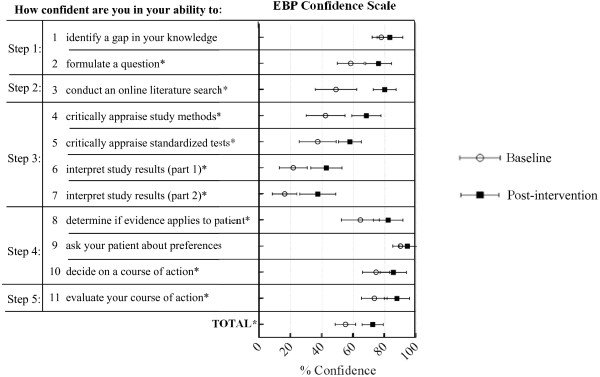
Illustrates pre-post group mean scores on individual items of the Evidence Based Practice Confidence (EPIC) Scale. Evidence based practice step (1-5) corresponding to each item is indicated on the left. Open circles indicate baseline mean, closed boxes indicate post-program mean, horizontal bars indicate 95% confidence intervals. ‘*’ indicates statistically significant differences in post-hoc analysis.